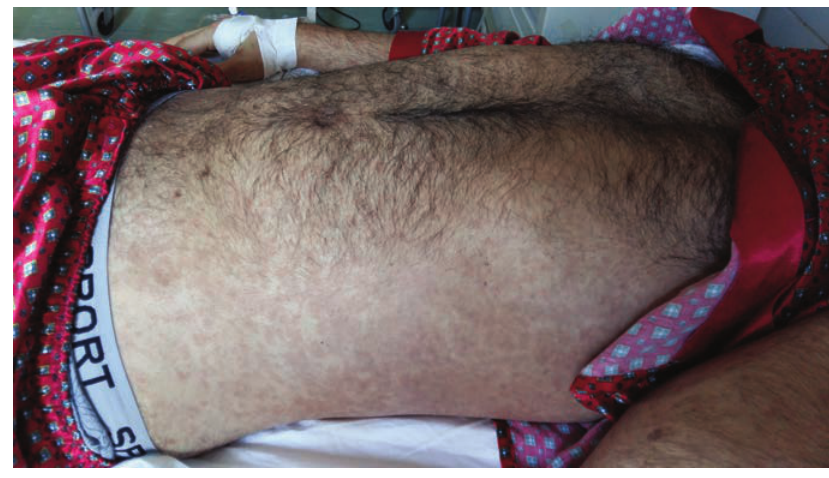
Figure 1. Patient on